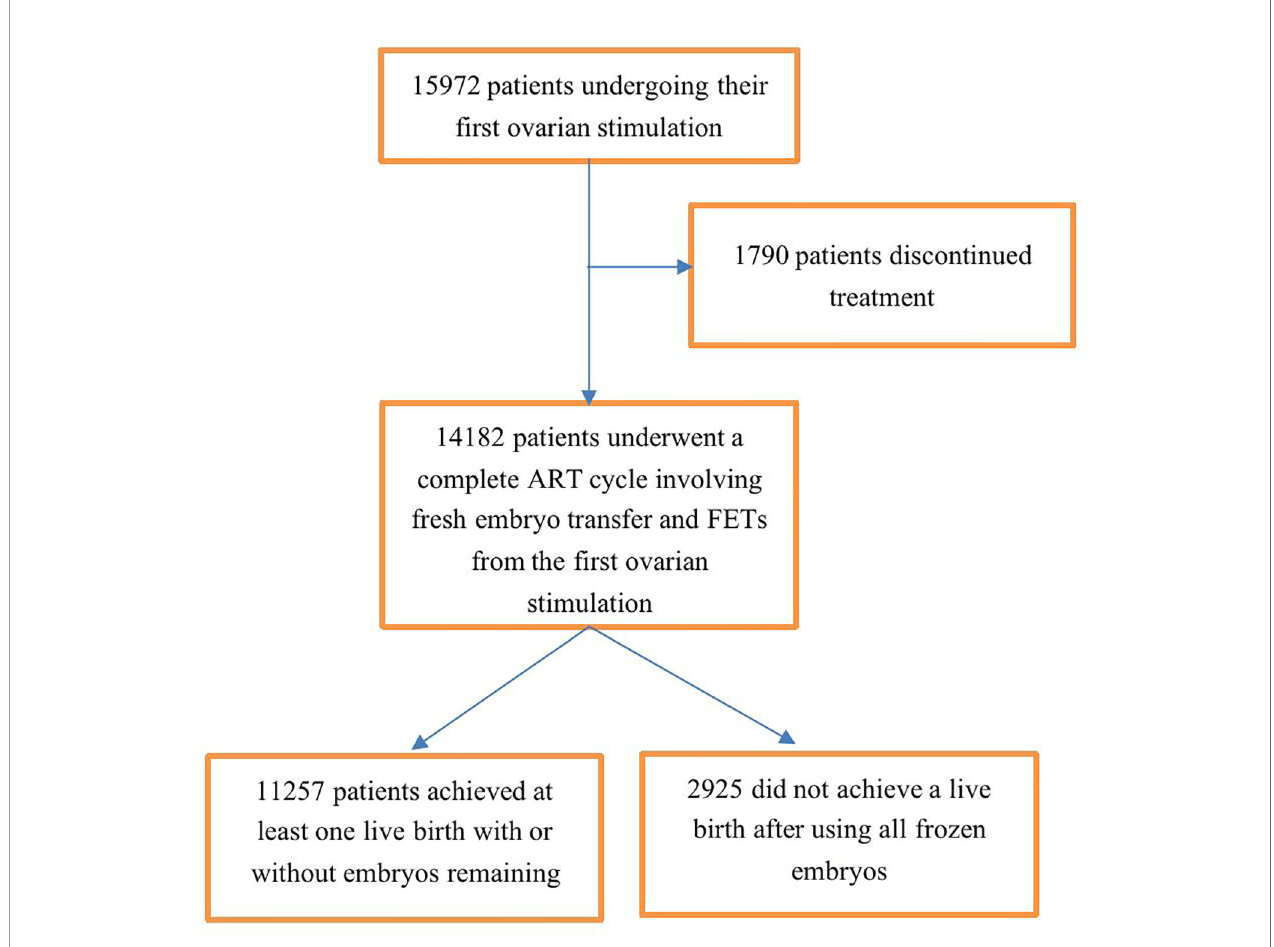
FIGURE 1 | Flowchart of patient selection. A complete ART treatment cycle is de fi ned as achieving at least one live birth in the fresh cycle or subsequent frozen embryo transfer (FET) cycles with or without embryos remaining afterward or is de fi ned as not achieving a live birth after using all fresh and frozen